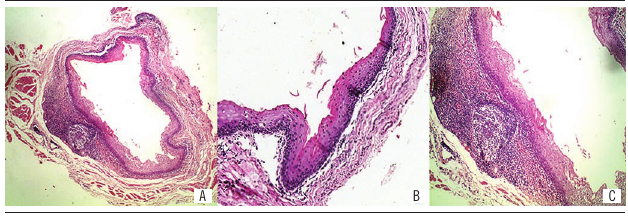
figurE 2 − Histopathological aspect of OLEC A and B) presence of a pathological cavity covered by parakeratinized stratified squamous epithelium surrounded by a connective fibrovascular tissue capsule (100×); C) presence of lymphoid tissue in the cystic capsule, and germinal centers (400×). OLEC: oral lymphoepithelial